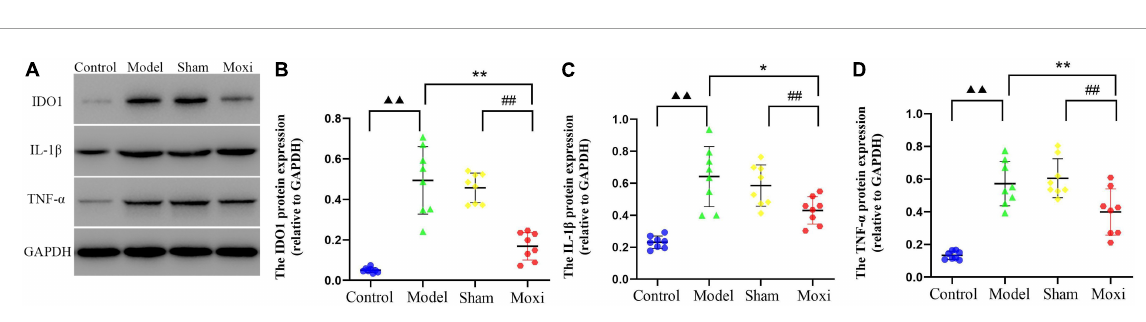
FIGURE4 Effect of moxibustion on protein expressions of IDO1, IL-1 β , and TNF- α in the colon. (A) Western blot bands of IDO1, IL-1 β , and TNF- α protein expression, (B) IDO1 protein, (C) IL-1 β protein, and (D) TNF- α protein expression in the colon of rats in each group. n = 8 per group. (cid:78)(cid:78) P < 0.01 vs. control group; * P < 0.05, ** P < 0.01 vs. model group; ## P < 0.01 vs. moxibustion